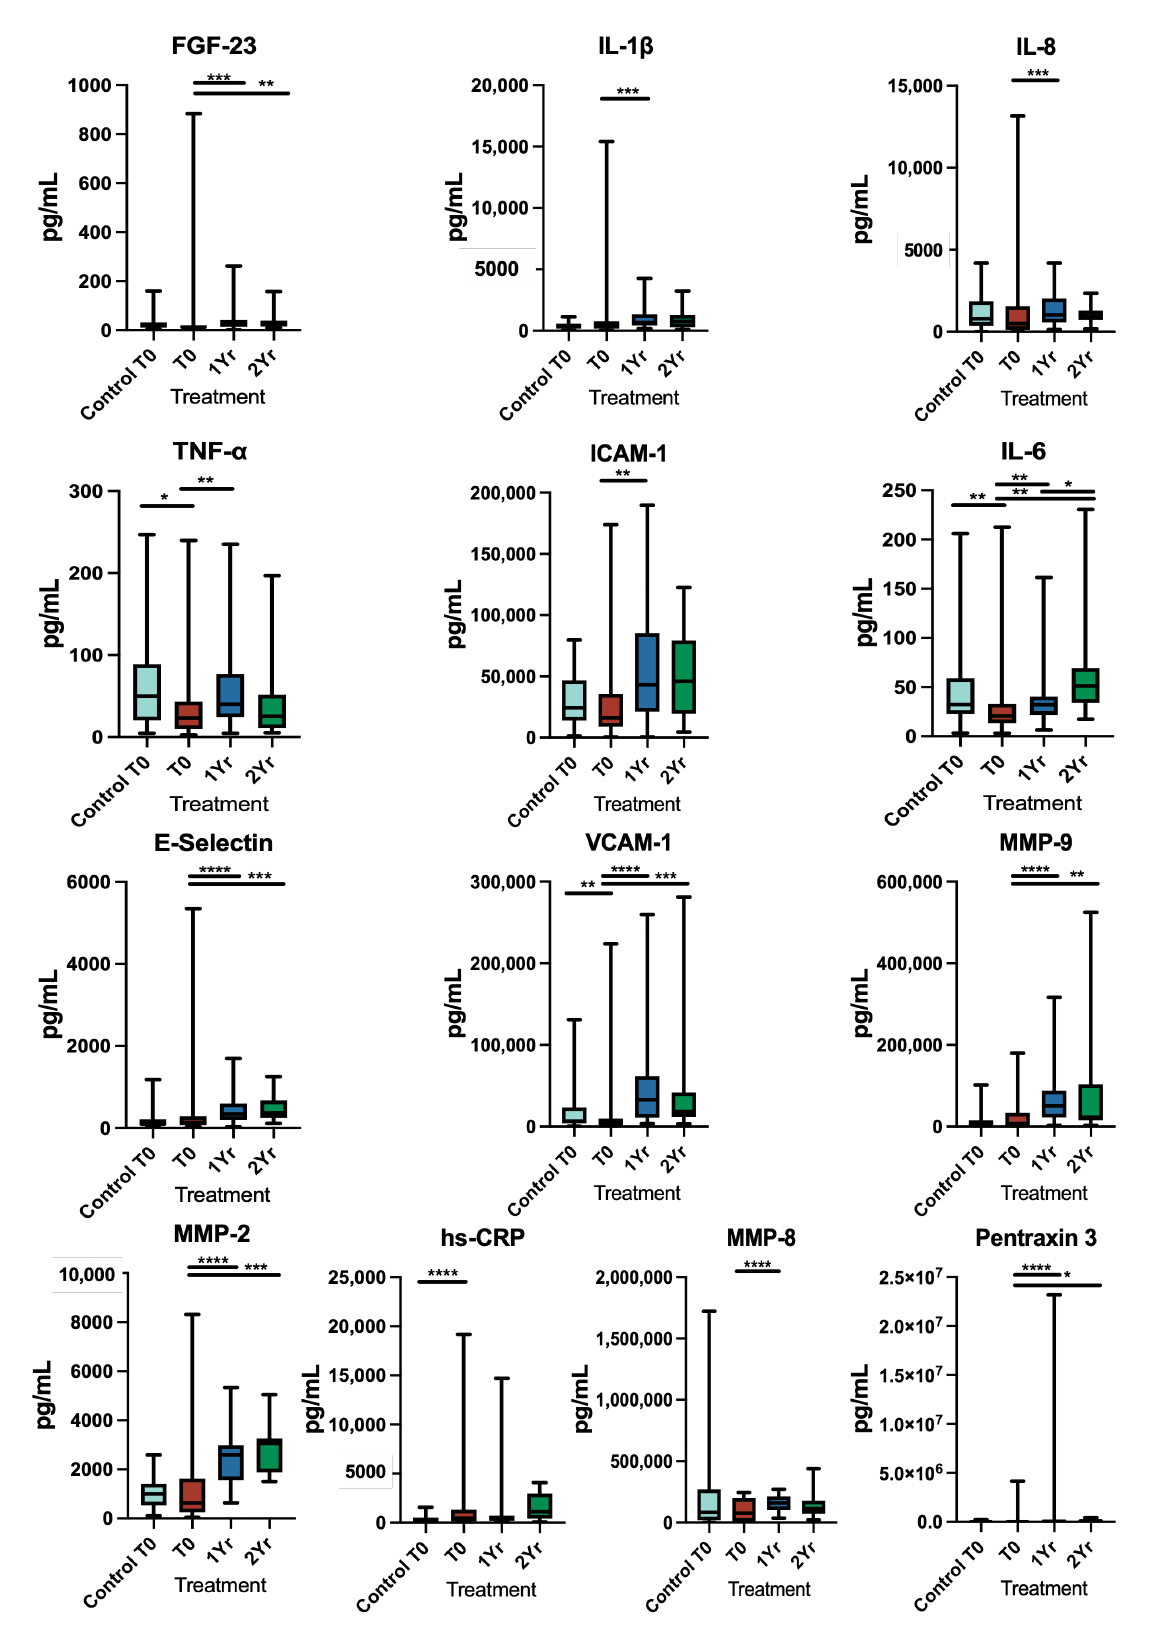
Figure 1. Box plot showing salivary levels of inflammatory markers of treatment group at baseline (T0), one year (1 Yr), and two years (2 Yr); differences between medians were compared using Wilcoxon test; * ( p < 0.05), ** ( p < 0.01), *** ( p < 0.001), **** ( p <